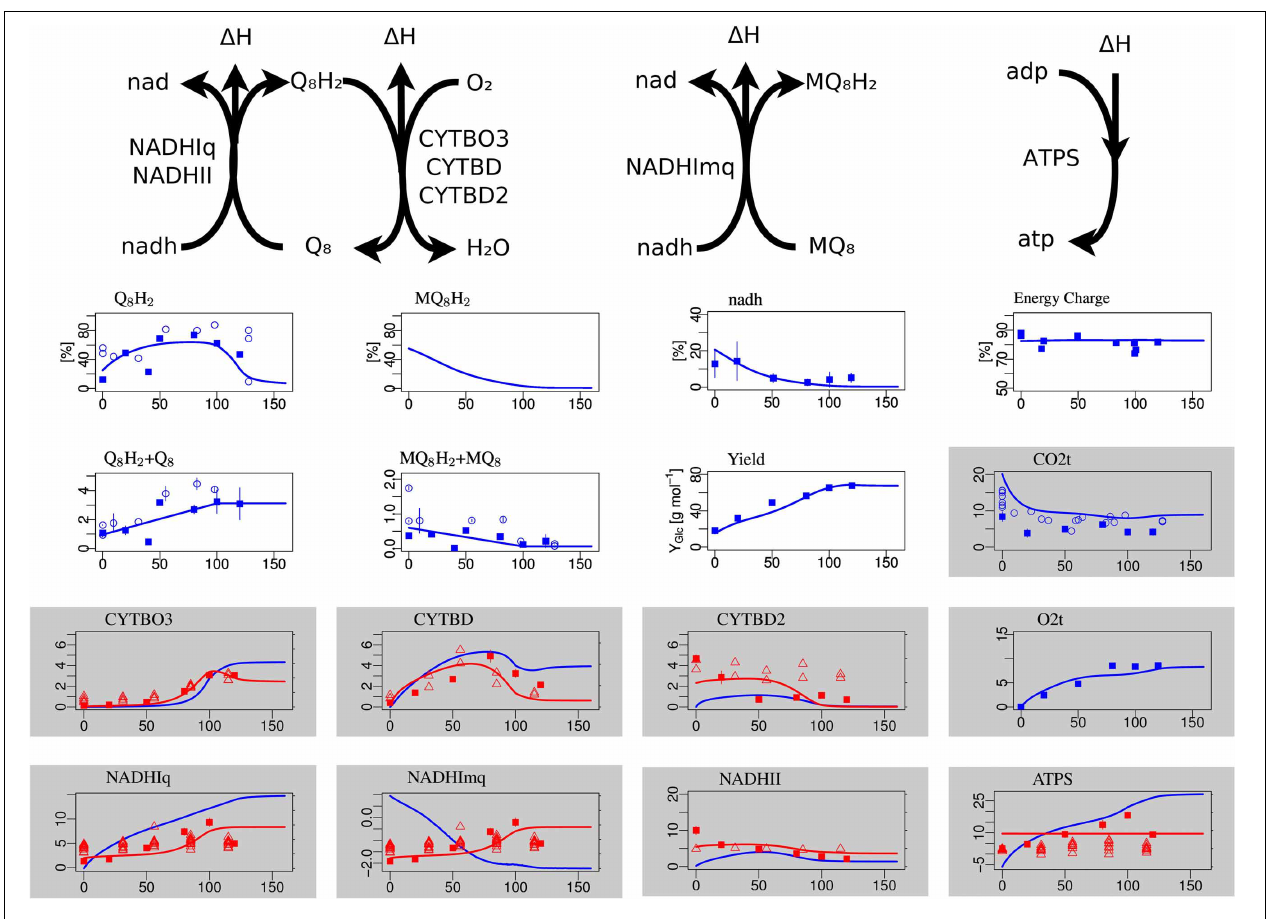
FIGURE 3 | Steady-state simulation results of the electron transport chain in comparison to measurement data. The plots with white background in the first row show the degree of reduction of ubiquinones, menaquinones and NADH and the ATP energy charge, respectively. The second row shows the total concentration (oxidized plus reduced form) of ubiquinone and menaquinone and the substrate-biomass yield Y . The labels